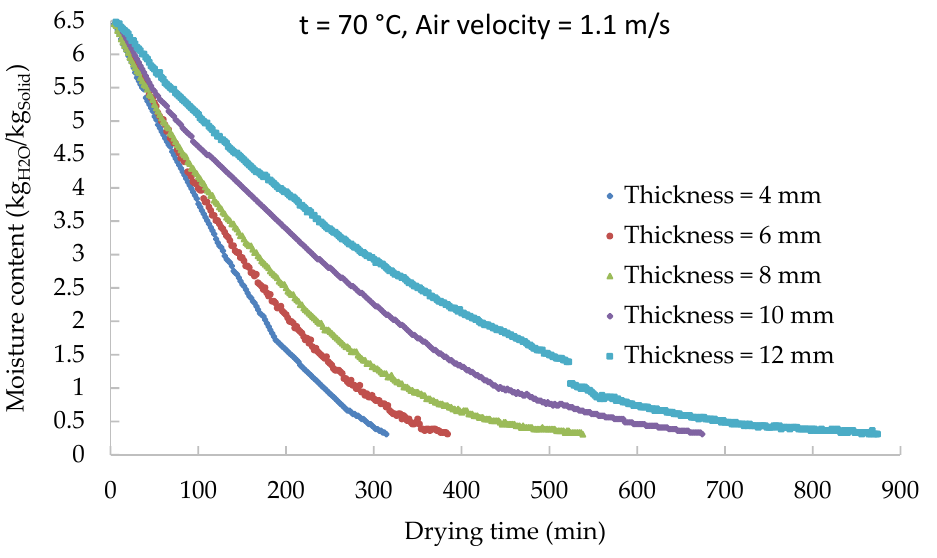
Figure 5. Effect of air relative humidity.